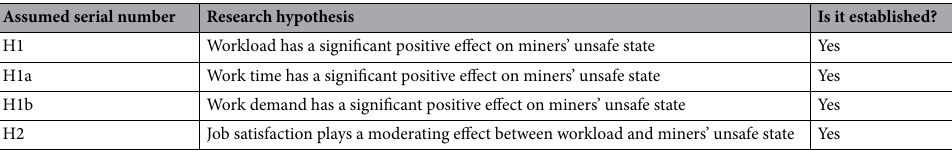
Table 10. Judgment results of hypothesis